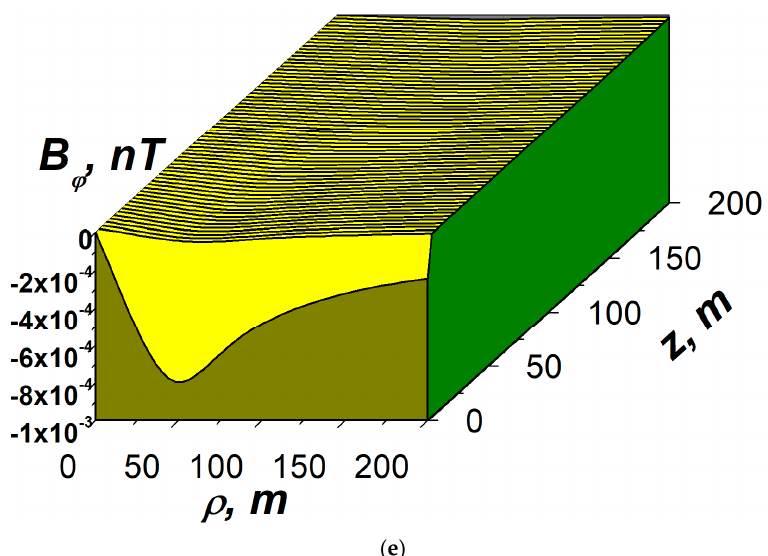
Figure 6. Typical distributions of concentrations of ions, densities of current, and the magnetic fi eld.